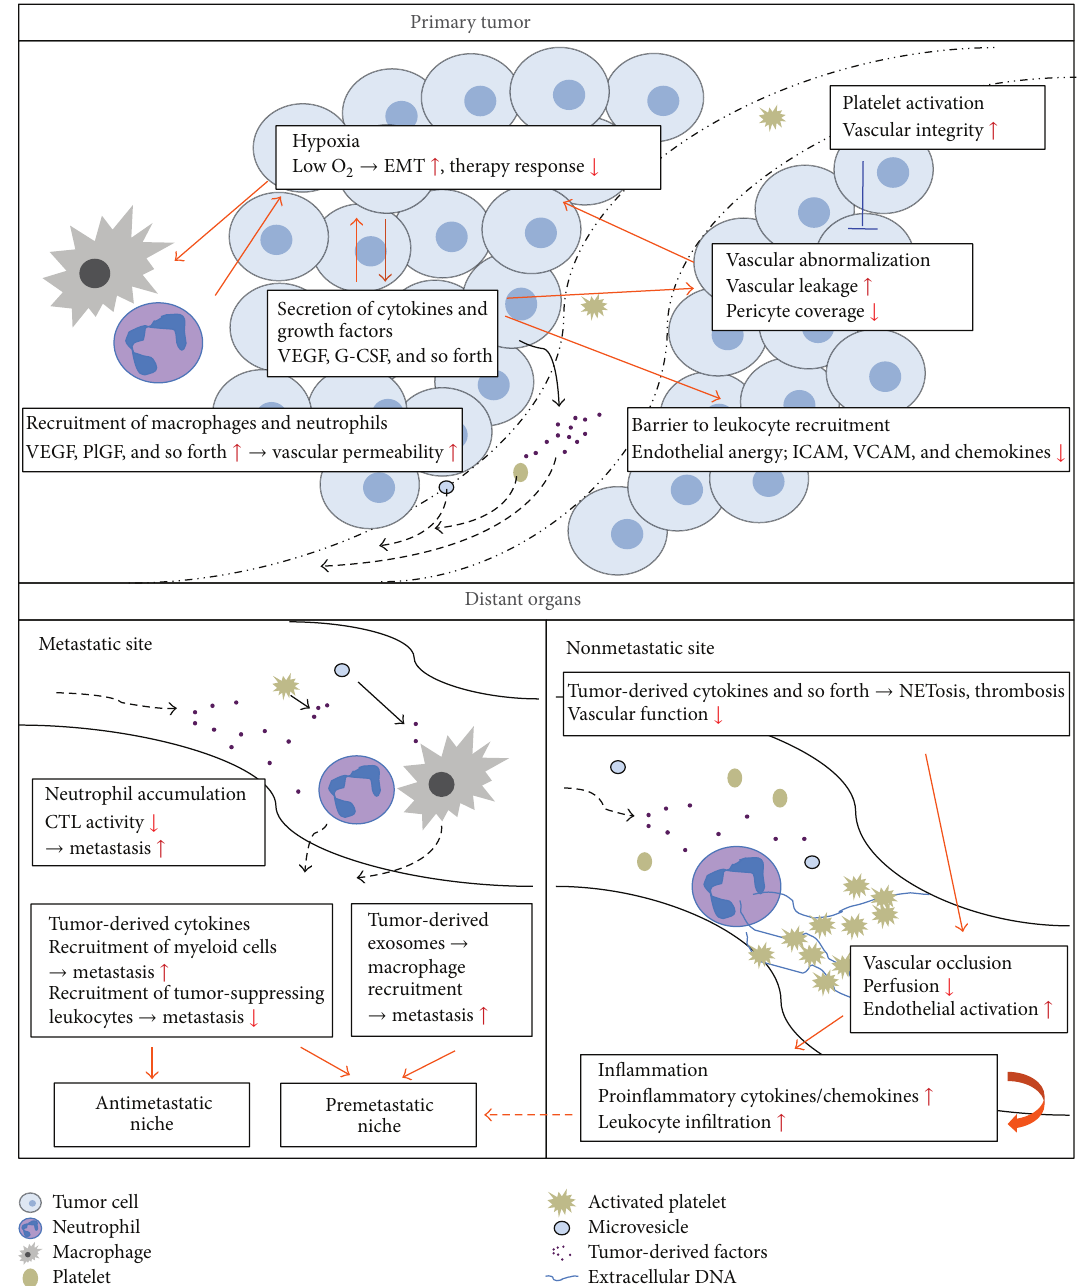
Figure 1: Altered function of blood vessels in tumor tissue and distant organs in individuals with cancer. Vascular function is impaired both at local tumor level and systemic level in an individual with cancer. The primary tumor secretes proangiogenic growth factors that contribute to vascular abnormalization with enhanced permeability and anergic endothelial cells within the tumor. The poor vascular function leads to hypoxia and subsequent recruitment of macrophages and neutrophils that further contribute to vascular permeability by secretion of additional proangiogenic factors. Hypoxia stimulates tumor invasiveness by induction of EMT and contributes to impaired therapy response. Effects on the vasculature are not limited to the actual tumor, but altered vascular function is also found in distant organs of tumor-bearing individuals.Tumorcell-derivedcytokinesarespreadthroughoutthebodyinplasmaorascargoinplateletsormicrovesiclesandcancontribute to formation of pre- or antimetastatic niches in organs that exert sites for metastasis. These effects are mainly mediated by recruitment of leukocytes to the metastatic sites, which prepare the microenvironment to facilitate metastatic colonization. Furthermore, tumor-derived factors stimulate NETosis and thrombosis in distant organs leading to vascular occlusion and systemic inflammation also in organs that are not sites for